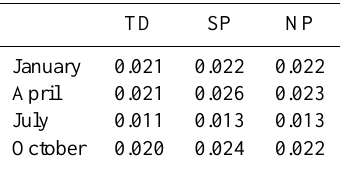
Table 3. SF 6 vertical gradient in pptkm − 1 between 900hPa ( ∼ 1km) and 500hPa ( ∼ 4km) for the three configurations of LMDz (TD, SP and